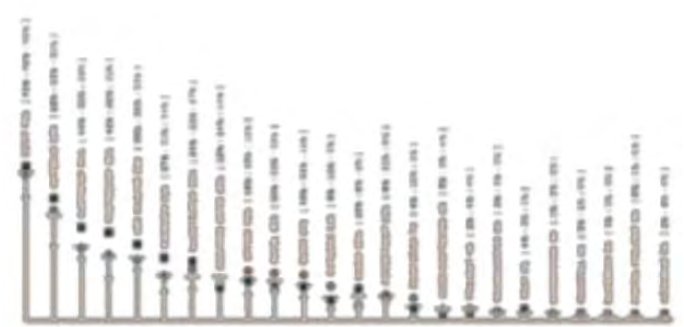
Figure 11. Key skillsrated according to job